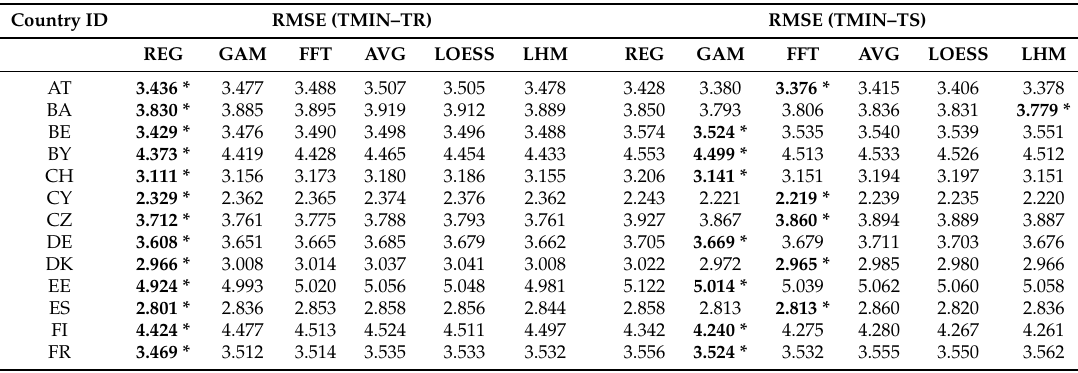
Table 5. Summary of the in-sample (TR) and out-of-sample (TS) errors for the minimum temperatures, obtained with all the different methods and for all the countries. The bold values with * indicate the best method for each country and